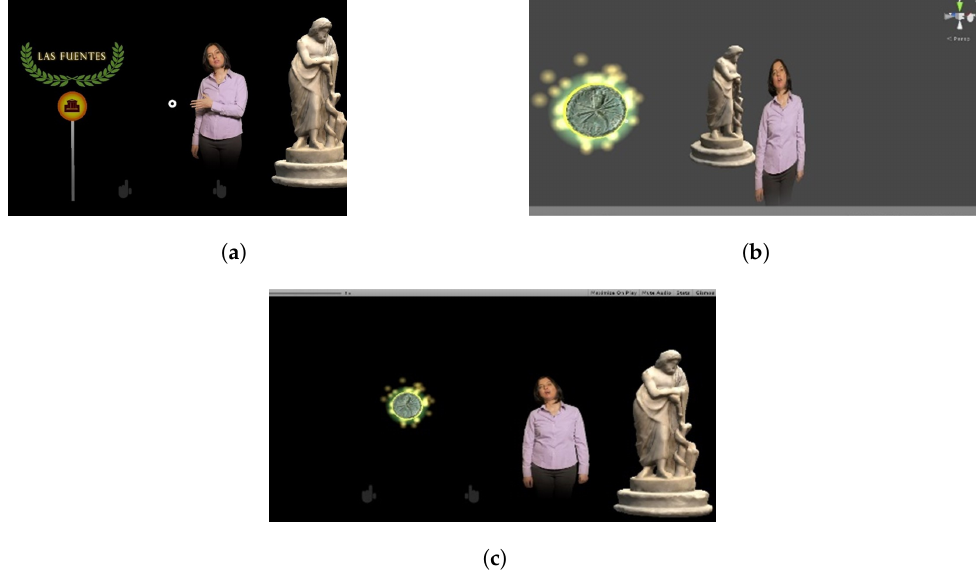
Figure 10. Interaction test examples: ( a – c ) images show different moments of the test